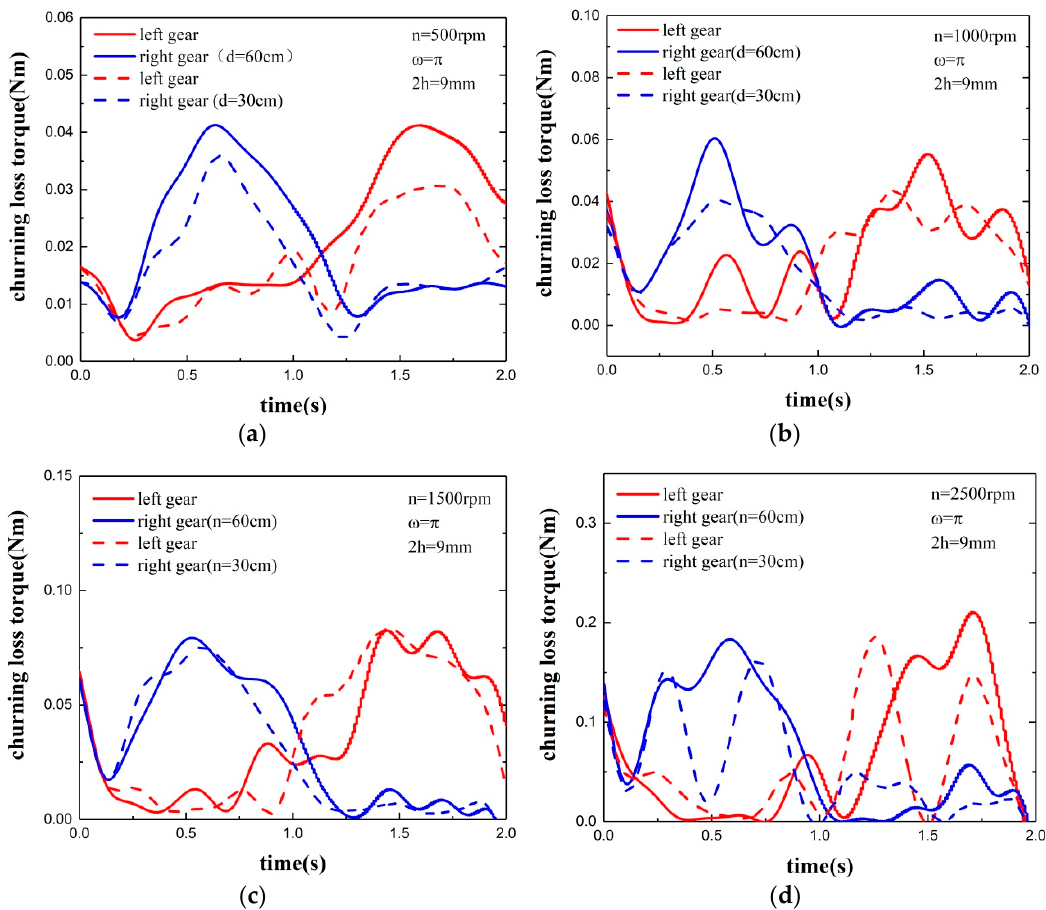
Figure 16. Influence of the magnitude of the sinusoidal motion at different rotating speeds. ( a ) Cases with n = 500 rpm; ( b ) Cases with n = 1000 rpm; ( c ) Cases with n = 1500 rpm; ( d ) Cases with n = 2500